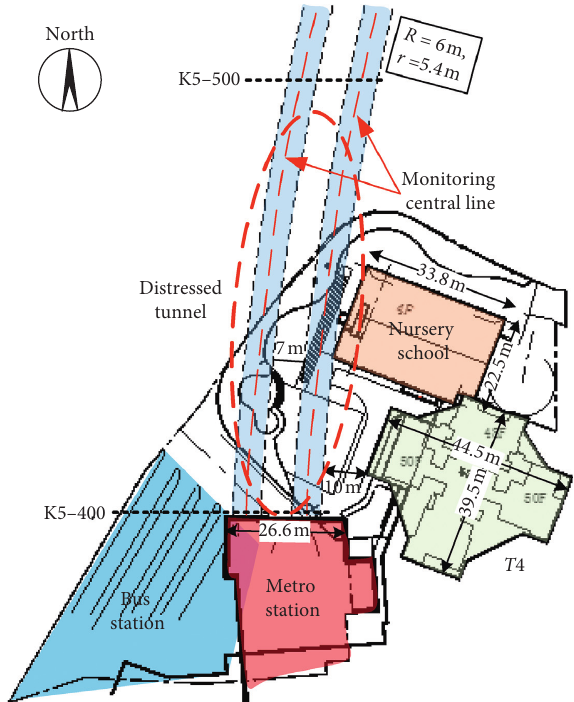
Figure 2: Positions with respect to the tunnel.